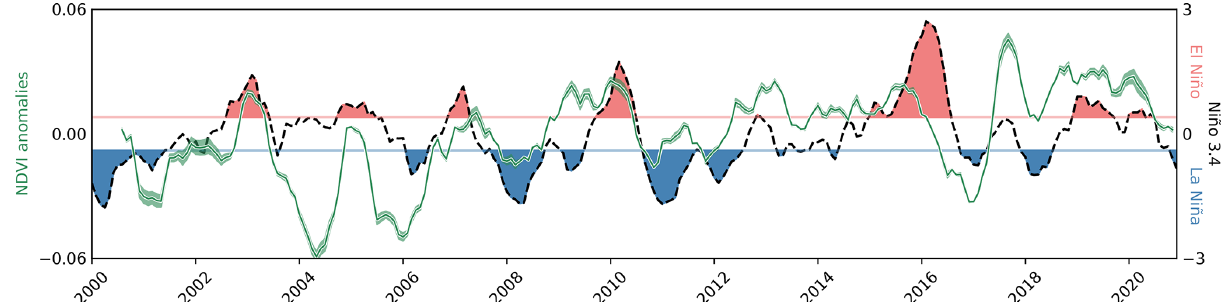
Figure 8. Seven-month running average of monthly NDVI anomalies for the RSB domain and unsmoothed monthly 3-month shifted Niño 3.4 SSTa time series El Niño/La Niña events classified after Trenberth (1997) with a threshold value of ± 0.4. Shaded areas represent 1 σ of all valid